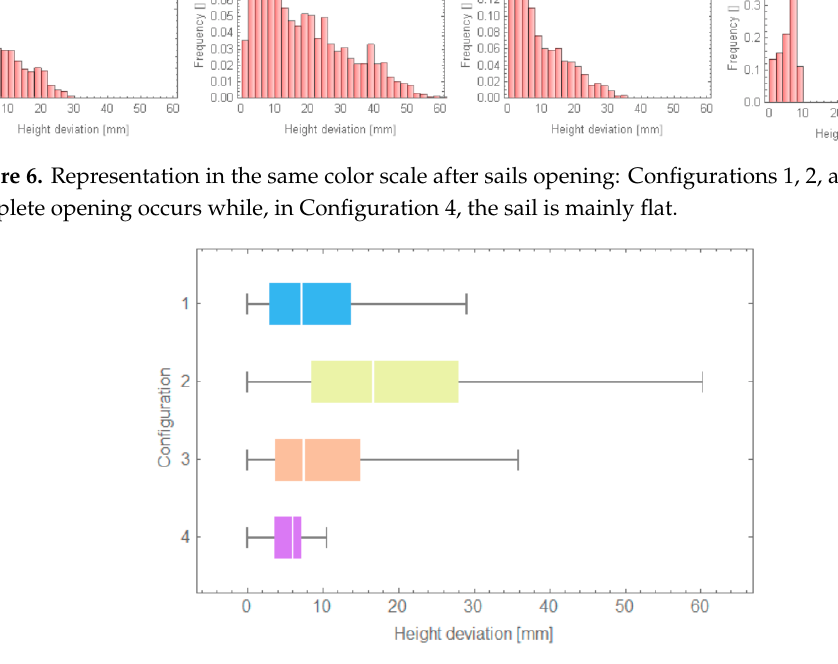
Figure 6. Representation in the same color scale after sails opening: Configurations 1, 2, and 3 lack in complete opening occurs while, in Configuration 4, the sail is mainly